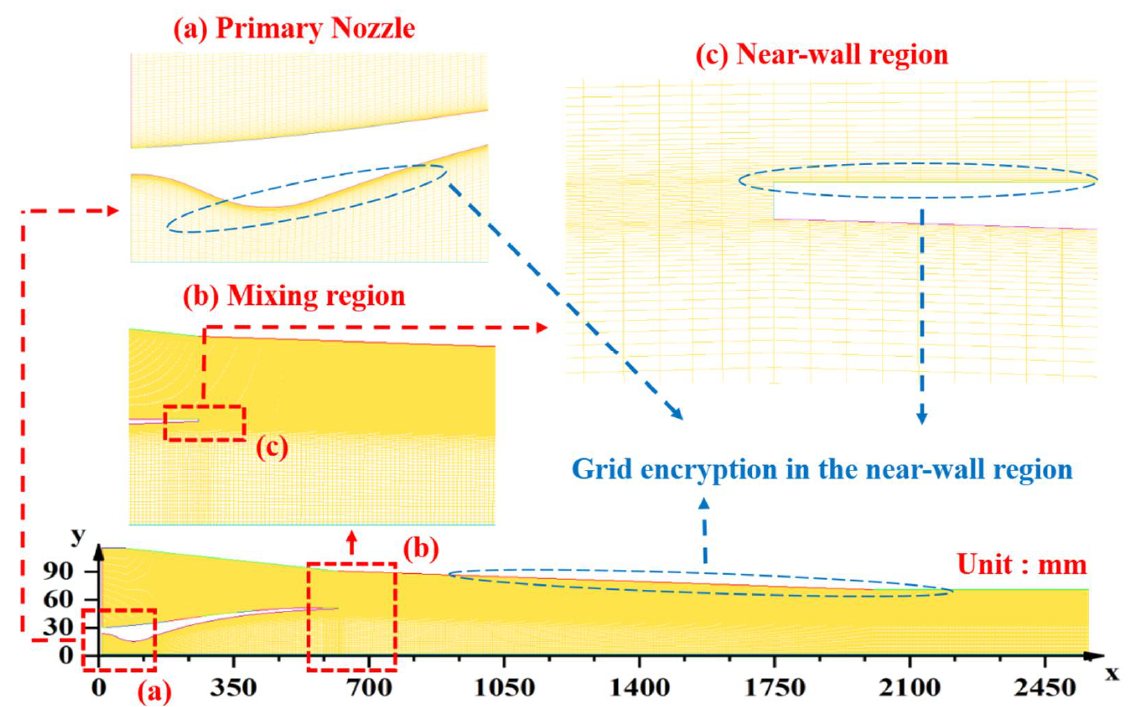
Figure 5. Grid division and encryption of the ejector.